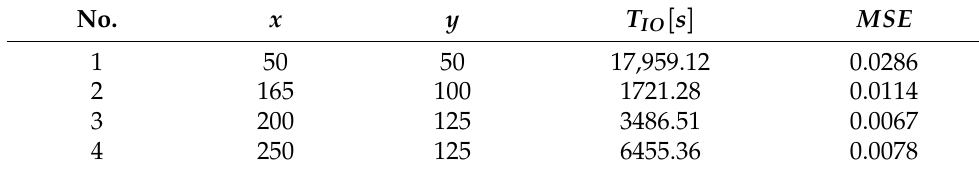
Table 2. Parameters of the IO model.